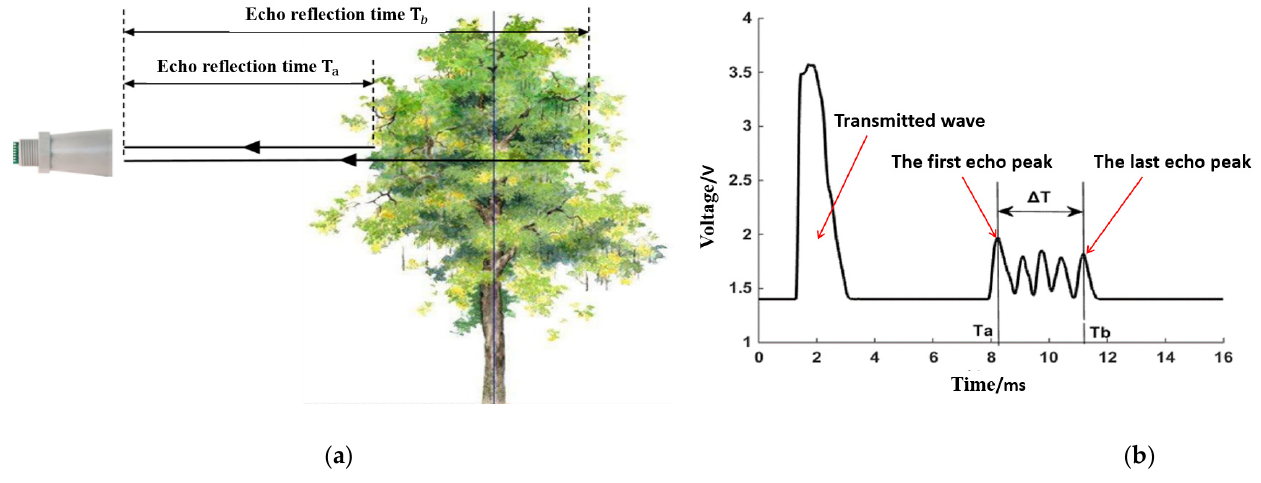
Figure 3. ( a ) Diagram of canopy thickness detection principle; ( b ) ultrasonic echo signal and echo interval time.